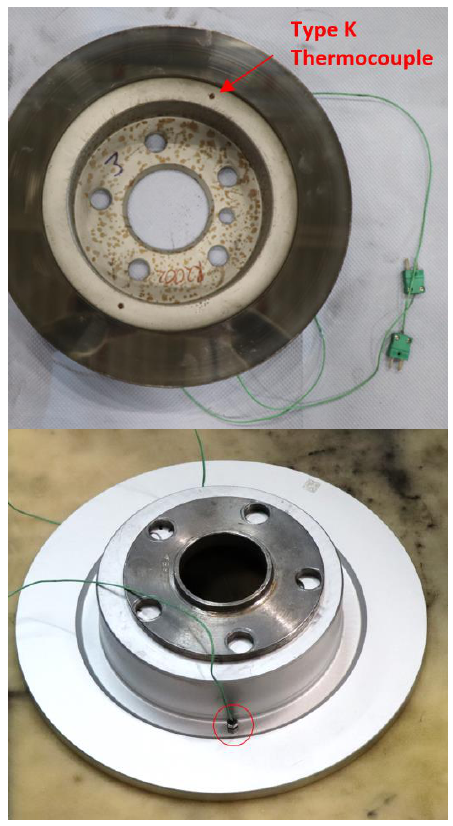
Figure A1. Temperature measurement at the brake disc with two type K thermocouples of class 1, IEC 584-3 K-NiCr/Ni with a tolerance of ± 1.5 ◦ C between − 40 and 1000 ◦ C and 1 Hz resolution.